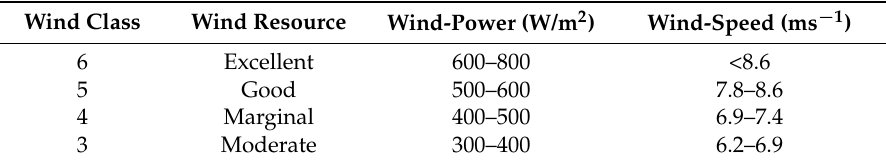
Table 2. Wind class and electricity capacity at the height of 50 m